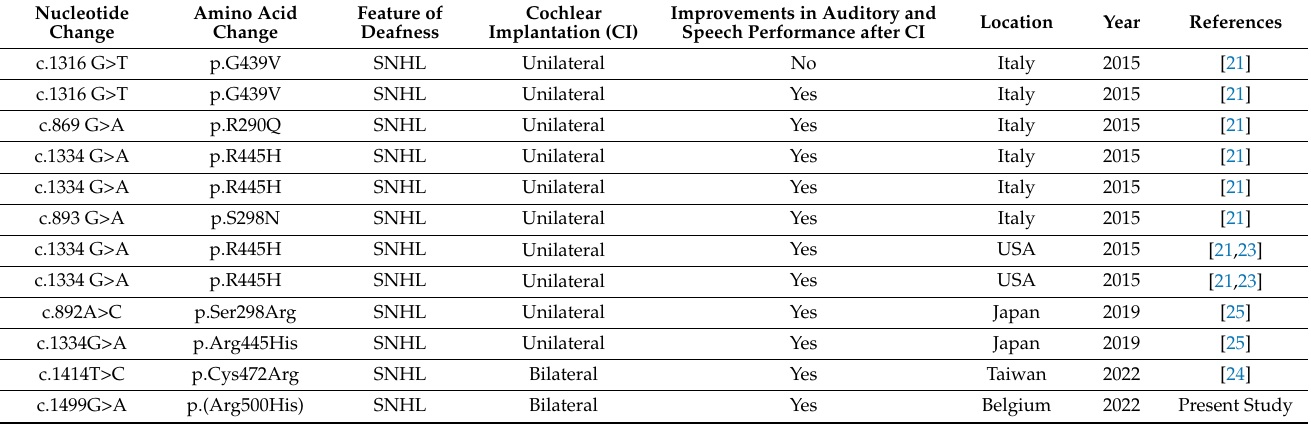
Table 1. Mutations in the OPA 1 gene reported in the literature in patients who underwent cochlear